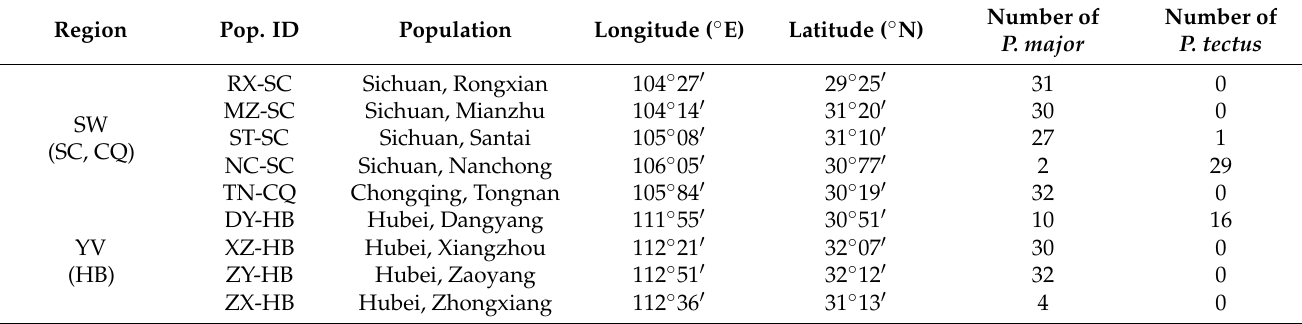
Table 1. Sample collection information for P. major and P. tectus used in this